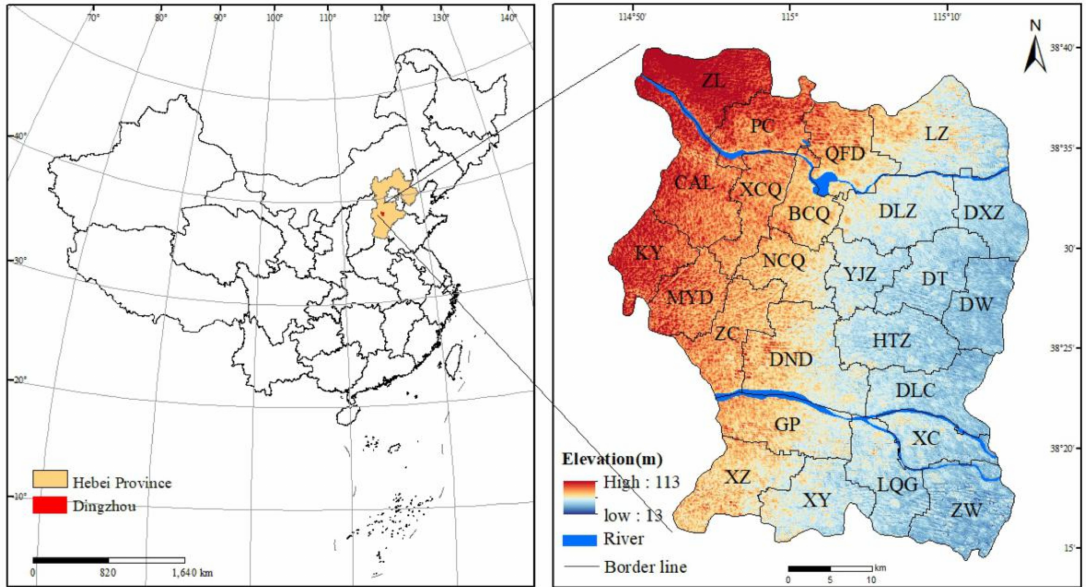
Figure 1. Location of Dingzhou City. Note: NCQ: Nancheng Qu Street, BCQ: Beicheng Qu Street, XCQ: Xicheng Qu Street, CAL: Chang’an Lu Street, LZ: Liuzao Town, QFD: Qingfeng Dian